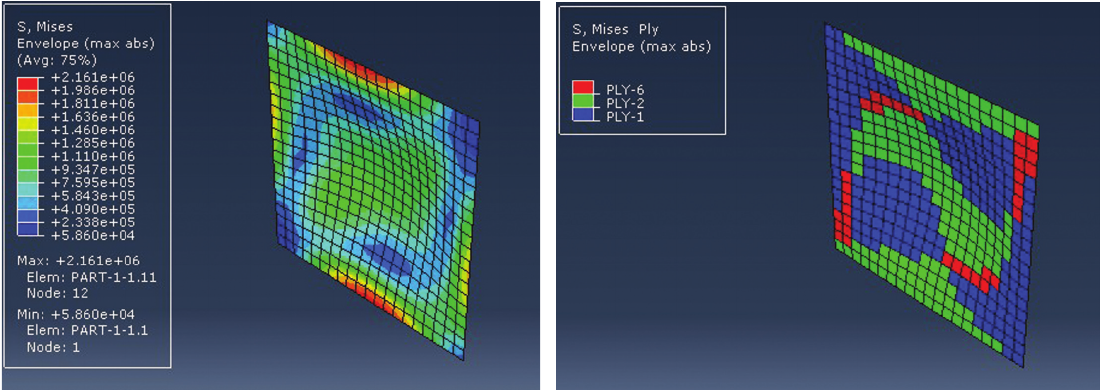
Figure 11 Maximum stress and subjected plies for rule operator-equipped GA